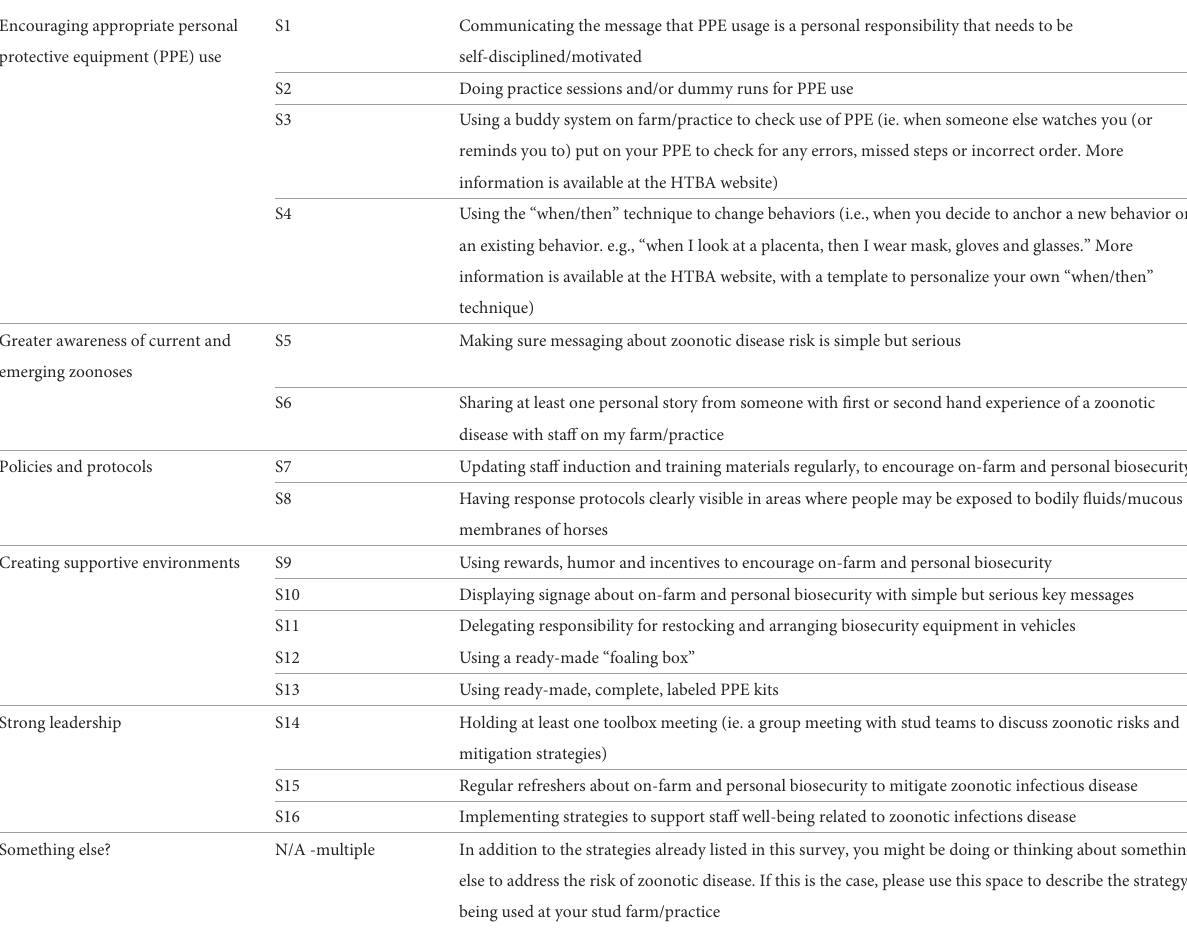
TABLE 1 Strategies included in the self-audit tool to improve on-farm and personal biosecurity practices on thoroughbred breeding farms/veterinary practices. Theme Strategy number Strategy wording, verbatim from self-audit survey tool Encouraging appropriate